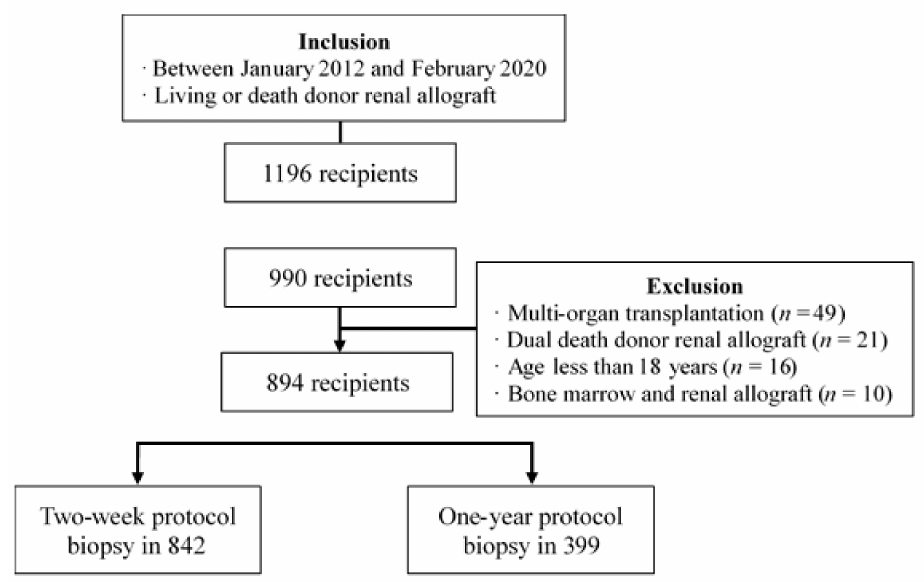
Figure 1. Flow diagram of study